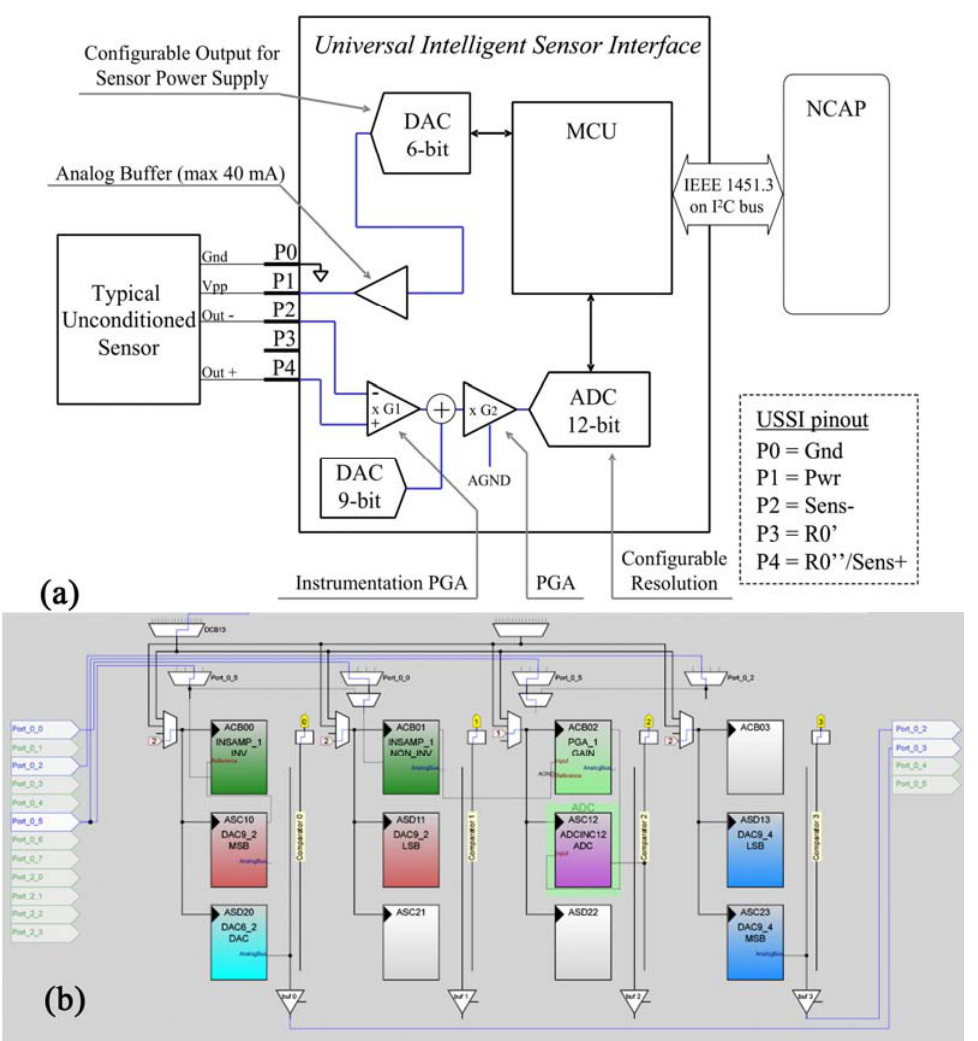
Figure 6. (a) Logical scheme of UISI conditioning front-end and (b) screen-shot of related implementation in PSoC device through by means of Graphic